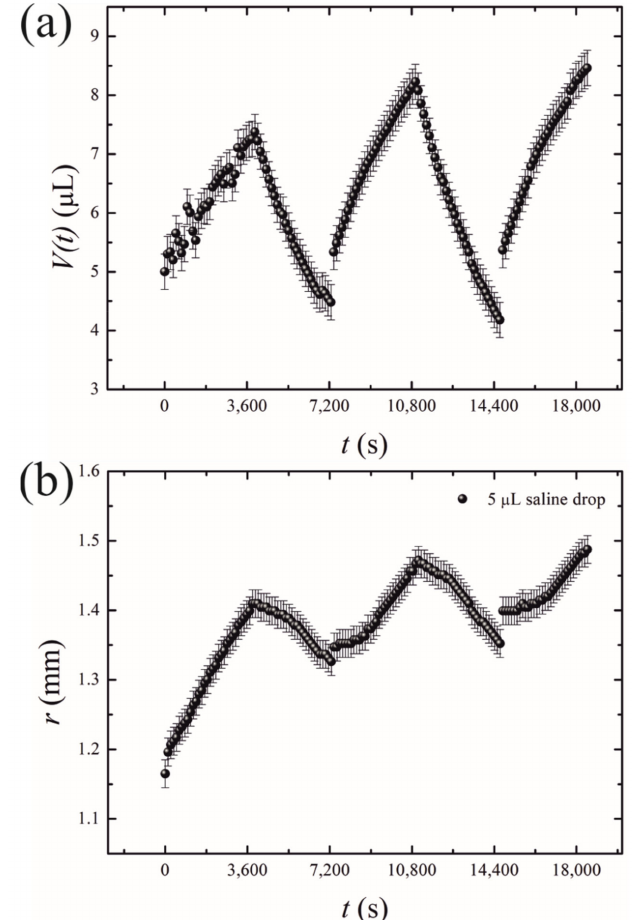
Figure 3. Oscillatory behavior of the droplets exposed to the osmotic mass transport/evaporation cycles is depicted. ( a ) Time evolution of the drop volume V(t) ; ( b ) the time dependence of the contact radius r .